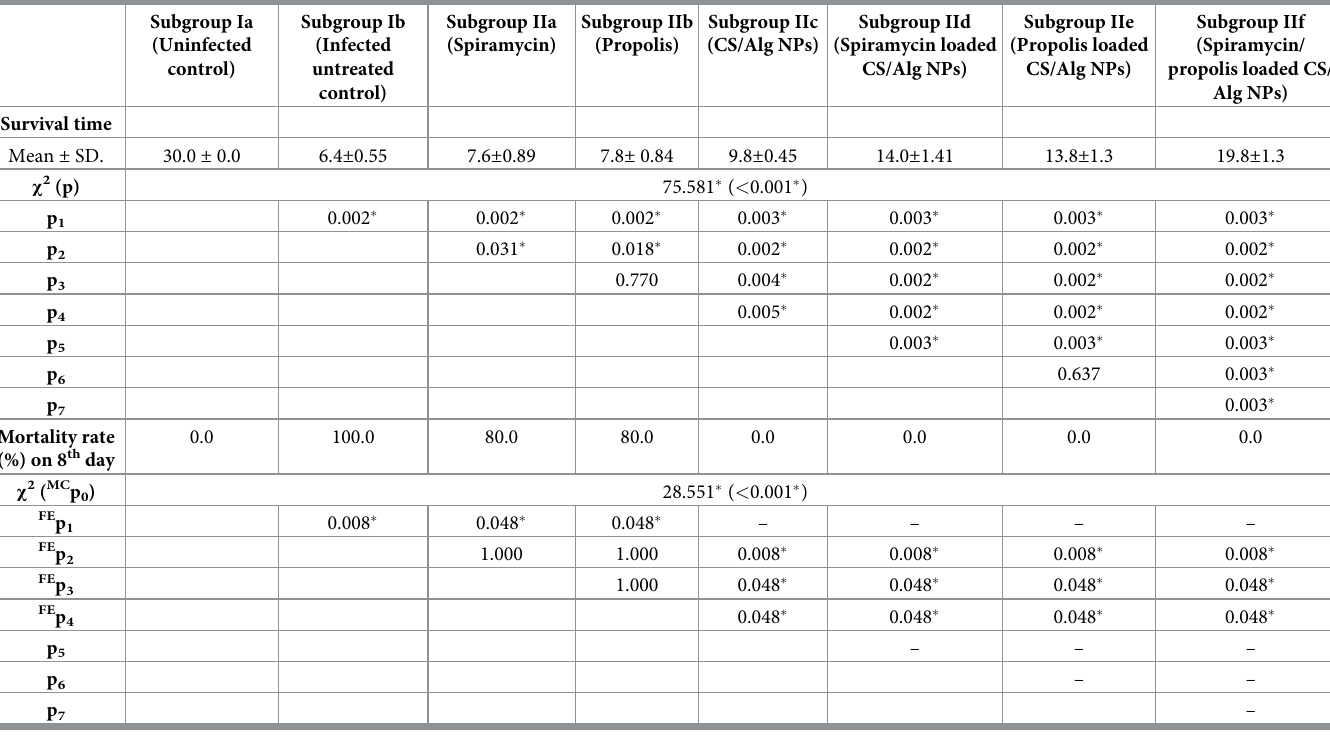
Table 2. Comparison between all subgroups regarding mice mean survival time and mortality rate on the eighth day post-infection. Subgroup Ia